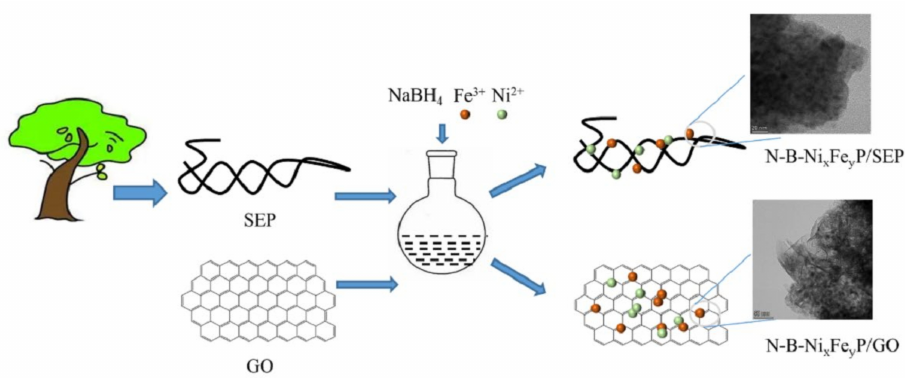
Scheme 1. Schematic representation for the preparation process of N-B-Ni x Fe y P/SEP and N-B- Ni x Fe y